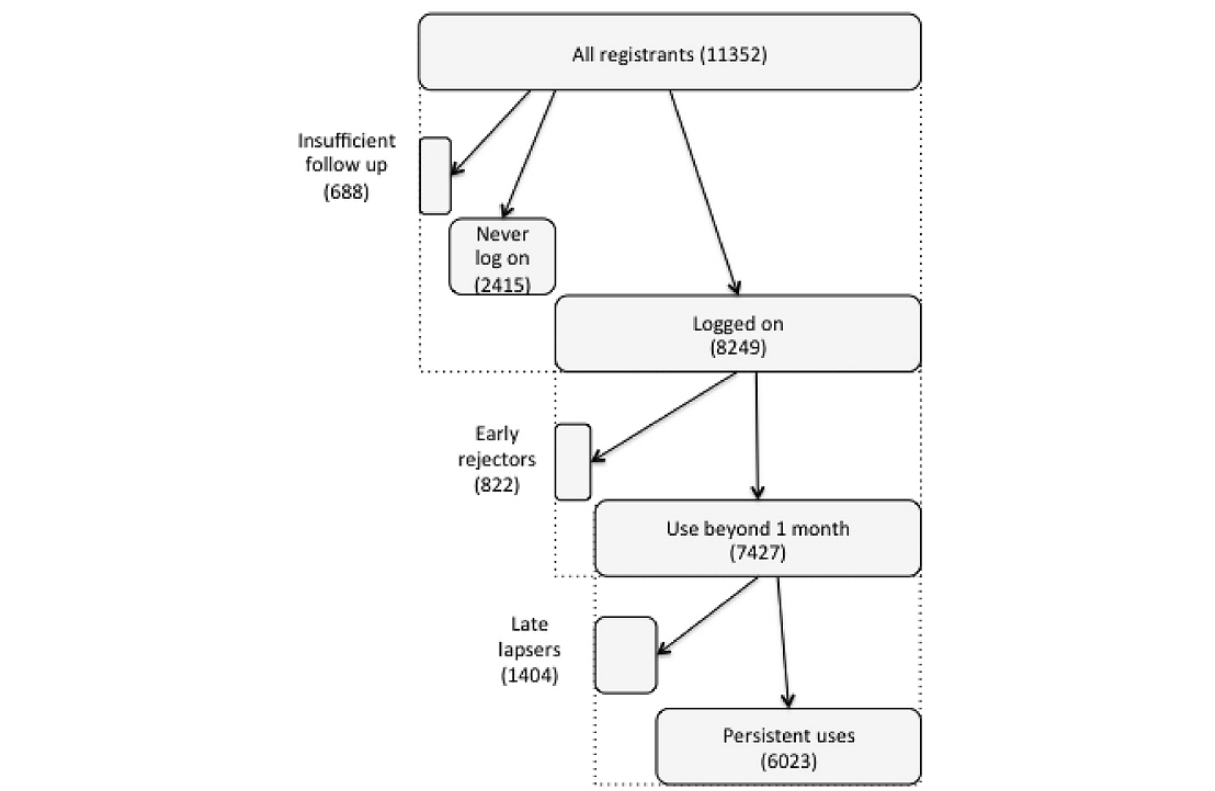
Figure 1. Classification of RPV users by logon